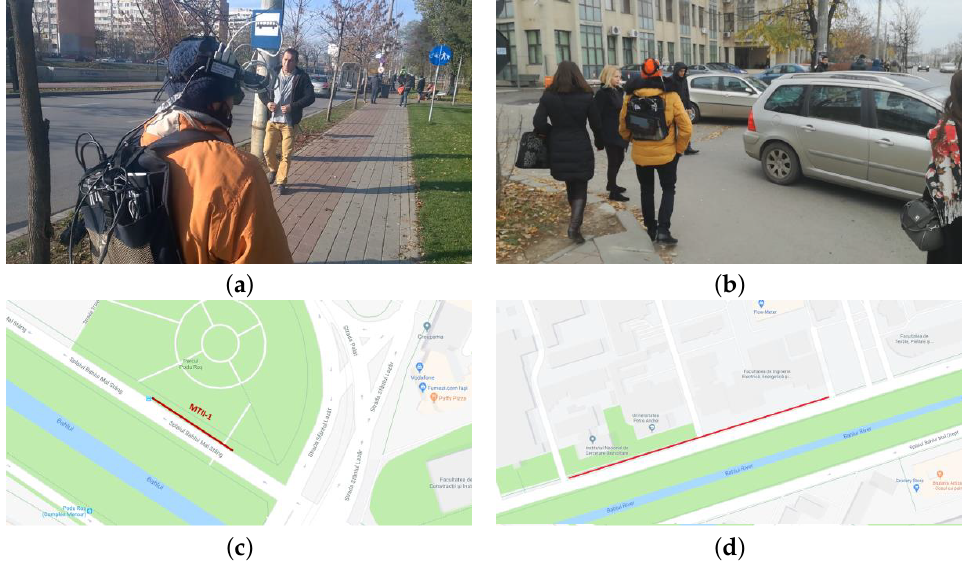
Figure 6. Examples of testing scene set ups for mobility tests in uncontrolled environments: ( a ) Walk- ing on the sidewalk (45 m path), static and dynamic obstacles on the path, bus stop (MT II-1); ( b ) walking on the sidewalk (250 m path), static and dynamic obstacles on the path (MT II-2); ( c ) geolocation of MT II-1 testing scenario; ( d ) geolocation of MT II-2 testing